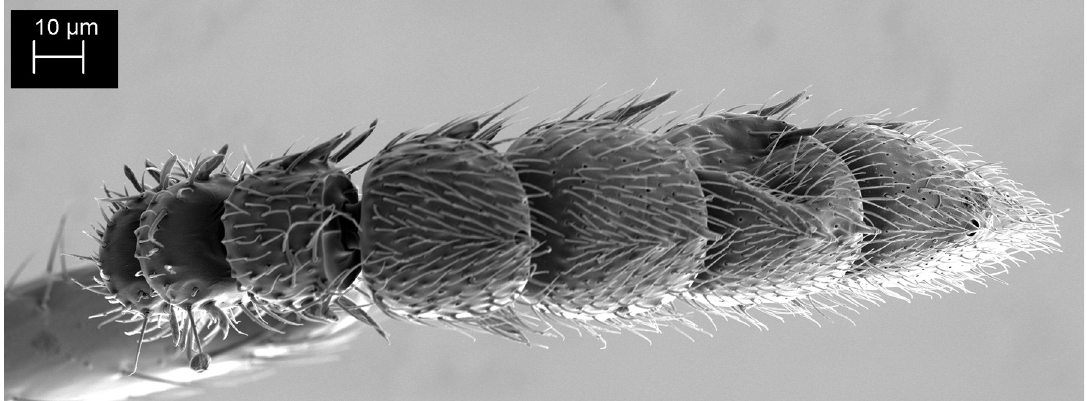
Fig 10. Telenomus nizwaensis Polaszek female. Scanning electron micrograph of terminal antennomeres showing papillary sensilla present on A8-11 and clearly absent from A7.